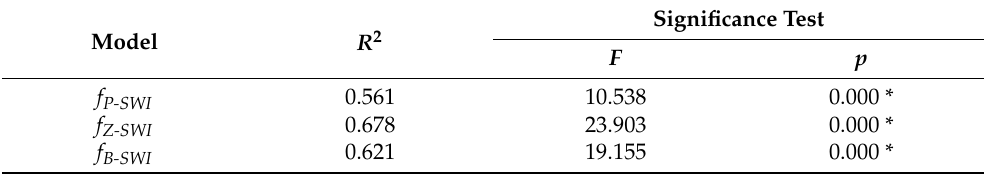
Table 2. Goodness-of-fit and F tests of the MLE models. Model